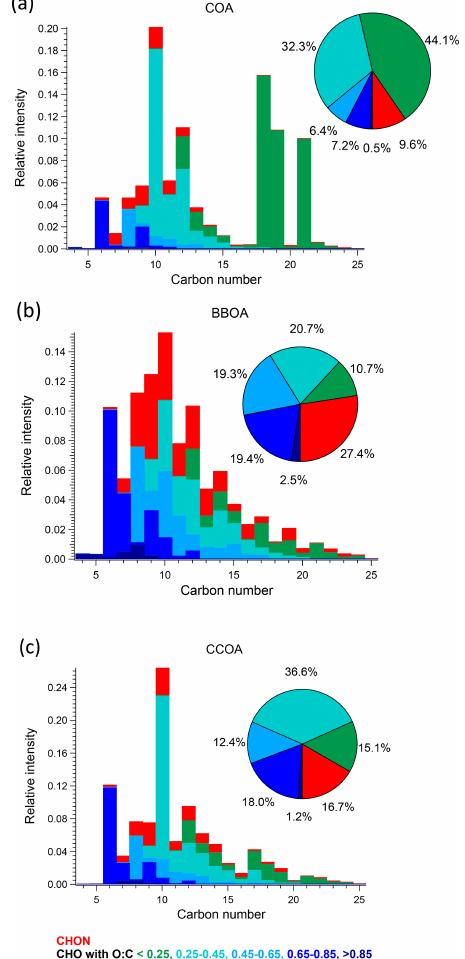
Figure 5. Carbon number distribution plots of three primary factors: (a) COA, (b) BBOA, and (c) CCOA, coloured by C x H y O z N 1–2 , and five different C x H y O z categories based on H:C ratio (H:C < 1.1, 1.1 < H:C < 1.3, 1.3 < H:C < 1.5, 1.5 < H:C < 1.7 and H:C > 1.7). Each distribution is normalised such that its sum is 1.